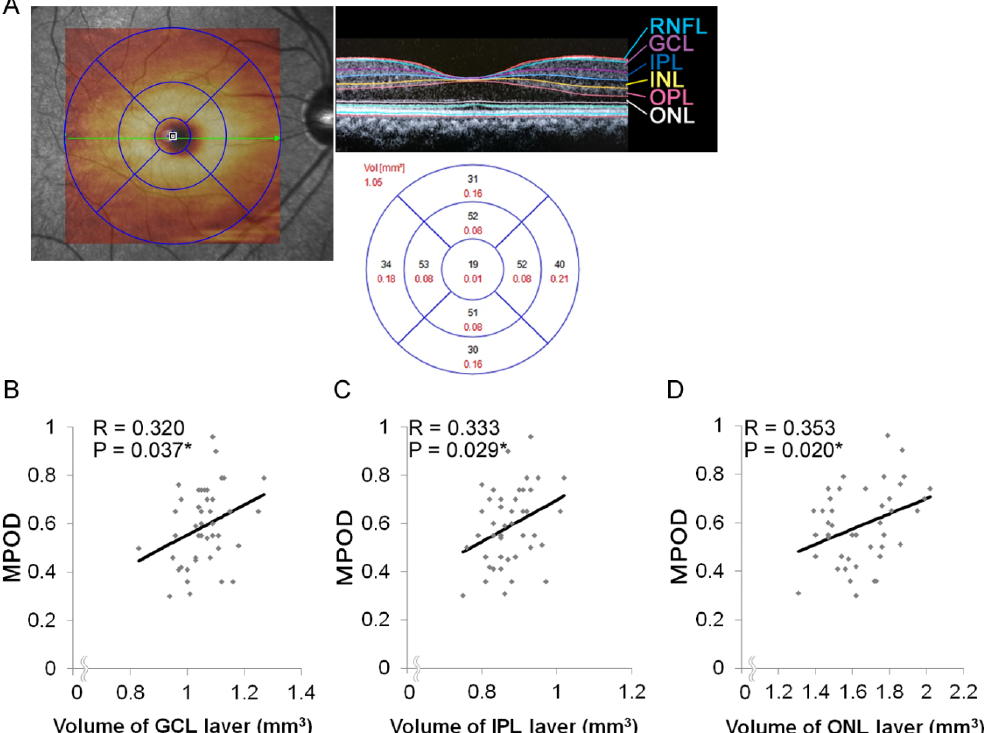
Figure 3. Correlation between the macular pigment optical density (MPOD) and volumes of retinal neural layers. (A) The macular area (left, the largest circle) was analyzed to calculate the volume of each retinal layer (right, upper), and the values obtained in each area (right, lower) were summed up to determine the values in the macular area (6-mm diameter). (B-D) MPOD was positively correlated with the retinal volumes of GCL (B), IPL (C), and ONL (D) in the macular area. RNFL retinal nerve fiber layer; GCL, ganglion cell layer; IPL, inner plexiform layer; INL, inner nuclear layer; OPL, outer plexiform layer; ONL, Outer nuclear layer; RPE, retinal pigment epithelium. * P < 0.05. Finally, we analyzed the correlations using multiple linear regression models (Table 3). After adjusting for age, which is reported to correlate negatively with MPOD [16,32–34], MPOD was positively correlated with CRT ( P = 0.023, R = 0.351, 95% CI, 0.001 to 0.006) and the retinal neural volume of the fovea ( P = 0.034, R = 0.326, 95% CI 0.287 to 7.077), parafovea ( P = 0.002, R = 0.460, 95% CI 0.298 to 1.237,), macula ( P = 0.003, R = 0.441, 95% CI 0.064 to 0.294), and the GCL ( P = 0.049, R = 0.302, 95% CI 0.001 to 1.197,), IPL ( P = 0.034, R = 0.326, 95% CI 0.067 to 1.619), and ONL ( P = 0.017, R = 0.364, 95% CI 0.061 to 0.588, P = 0.017) of the macular area. Table 3. Multiple linear regression analyses for the association between macular pigment optical density (MPOD) and retinal neural parameters.